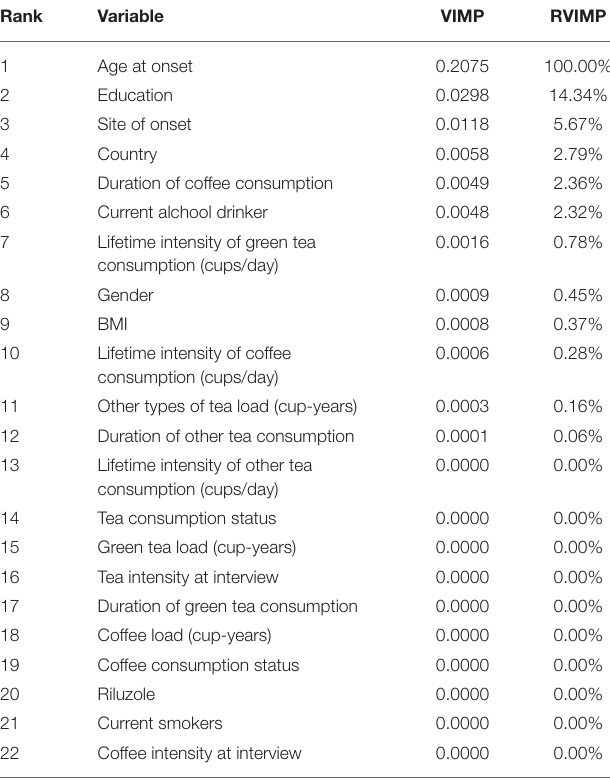
TABLE 4 | Variable importance (VIMP) and relative variable importance (RVIMP) values from conditional Random Forest algorithm (100,000 trees) of each candidate clinical, demographical, pathological, treatment, and coffee/tea consumption variables in explaining the variability of the 1 FS (log